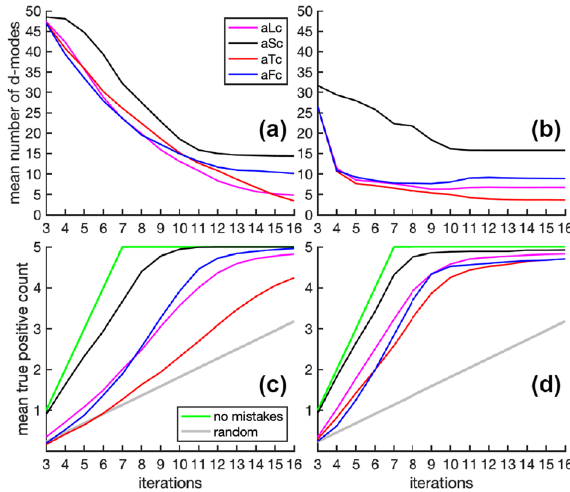
Figure 5. Characteristics of refining the working hypothesis by iterative learning. Mean number of d-modes versus iteration for (a) 500 samples and (b) 20,000 samples. Mean number of true positives for (c) 500 samples and (d) 20,000 samples. The result from random guessing among all remaining unlabeled molecules per iteration is shown by the gray line. The green line indicates mistake-free